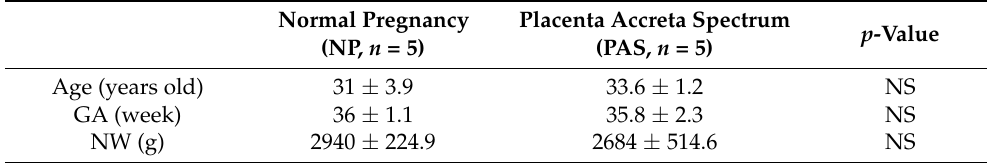
NW (g) 2940 ± 224.9 NS GA, gestational age; NW, newborn weight; Data are expressed as the mean ± S.D. NS: